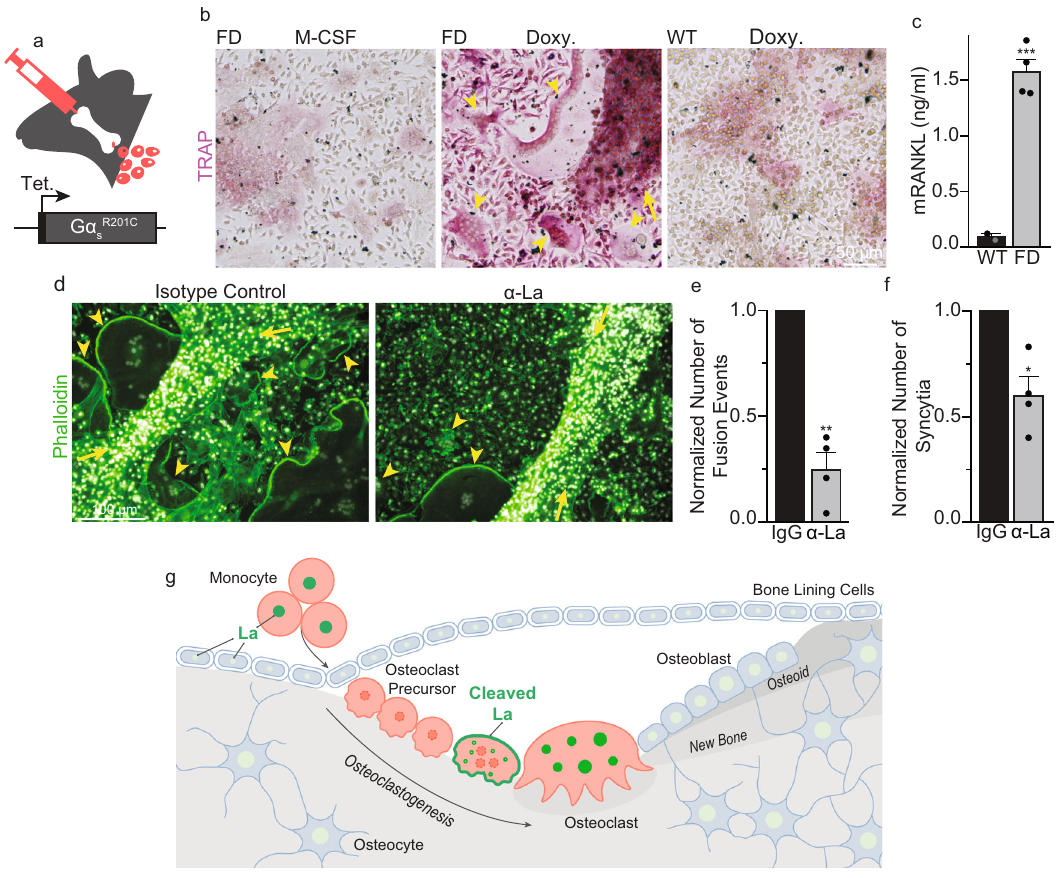
Fig. 8 | α -La treatment suppresses ectopic osteoclast formation in fi brous dysplasia explants.a Illustration of exvivo bone marrowculturesystembased on a tetracycline-inducible model of FD. b TRAP staining of bone marrow explants from a homozygous G α s R201C mouse (FD) and a wild-type littermate (WT). Explants were either cultured with M-CSF alone, or M-CSF and Doxy. c ELISA quanti fi cation ofmRANKLproducedinFDvsWTculturesfollowingDoxytreatment.(WT n =2;FD n =4) ( P =0.0005). d Representative images of FD explants activated by Doxy treatedwith6 μ g/mlisotypecontrolor α -LamAb. e Quanti fi cationofthenumberof fusions producing osteoclast syncytia with ≥ 3 nuclei. ( n =4) ( P =0.005) f Quanti fi cation of the number of osteoclast syncytia with ≥ 3 nuclei from d . ( n =4) ( P =0.02) In b and d , arrowheads denote multinucleated osteoclasts and arrows denote fi brouscellmassesdevelopedafterDoxyadditionandcharacteristicforFD. Statistical signi fi cance was assessed via one-tailed unpaired t-test in c or